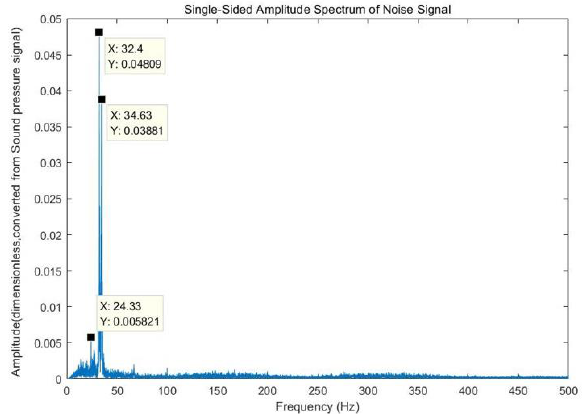
Figure 2. Single-sided amplitude spectrum .